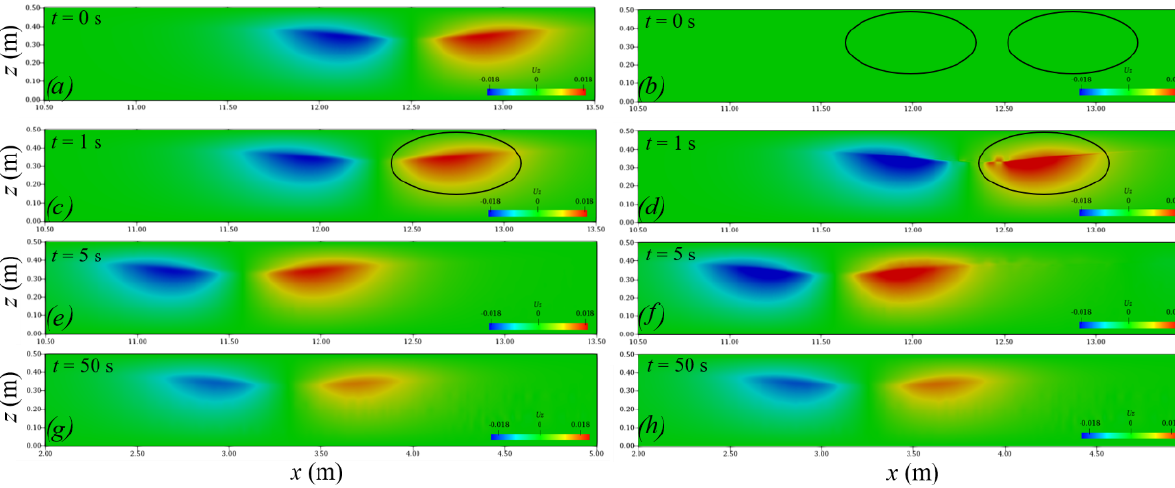
Figure 2. Comparison chart of the vertical velocity component field: DJL equation (left) and eKdV equation